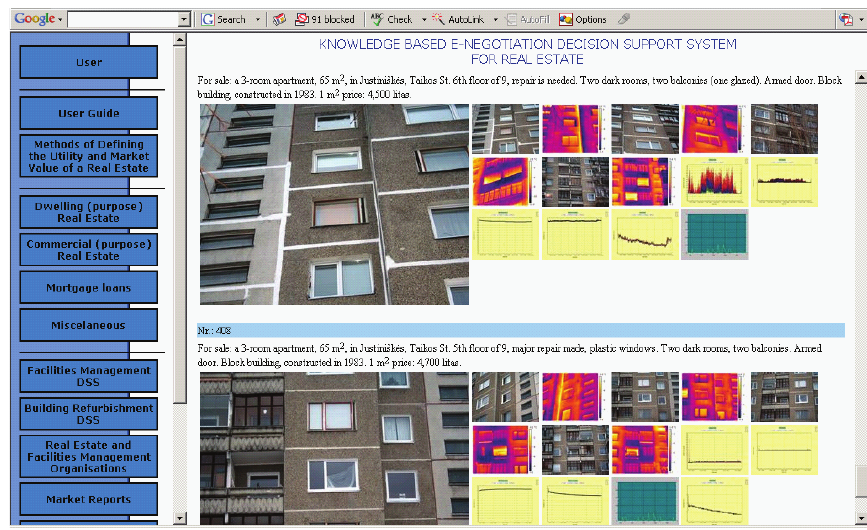
Figure 5. fragment of diagrams of indoor microclimate parameters and results of thermography measured by